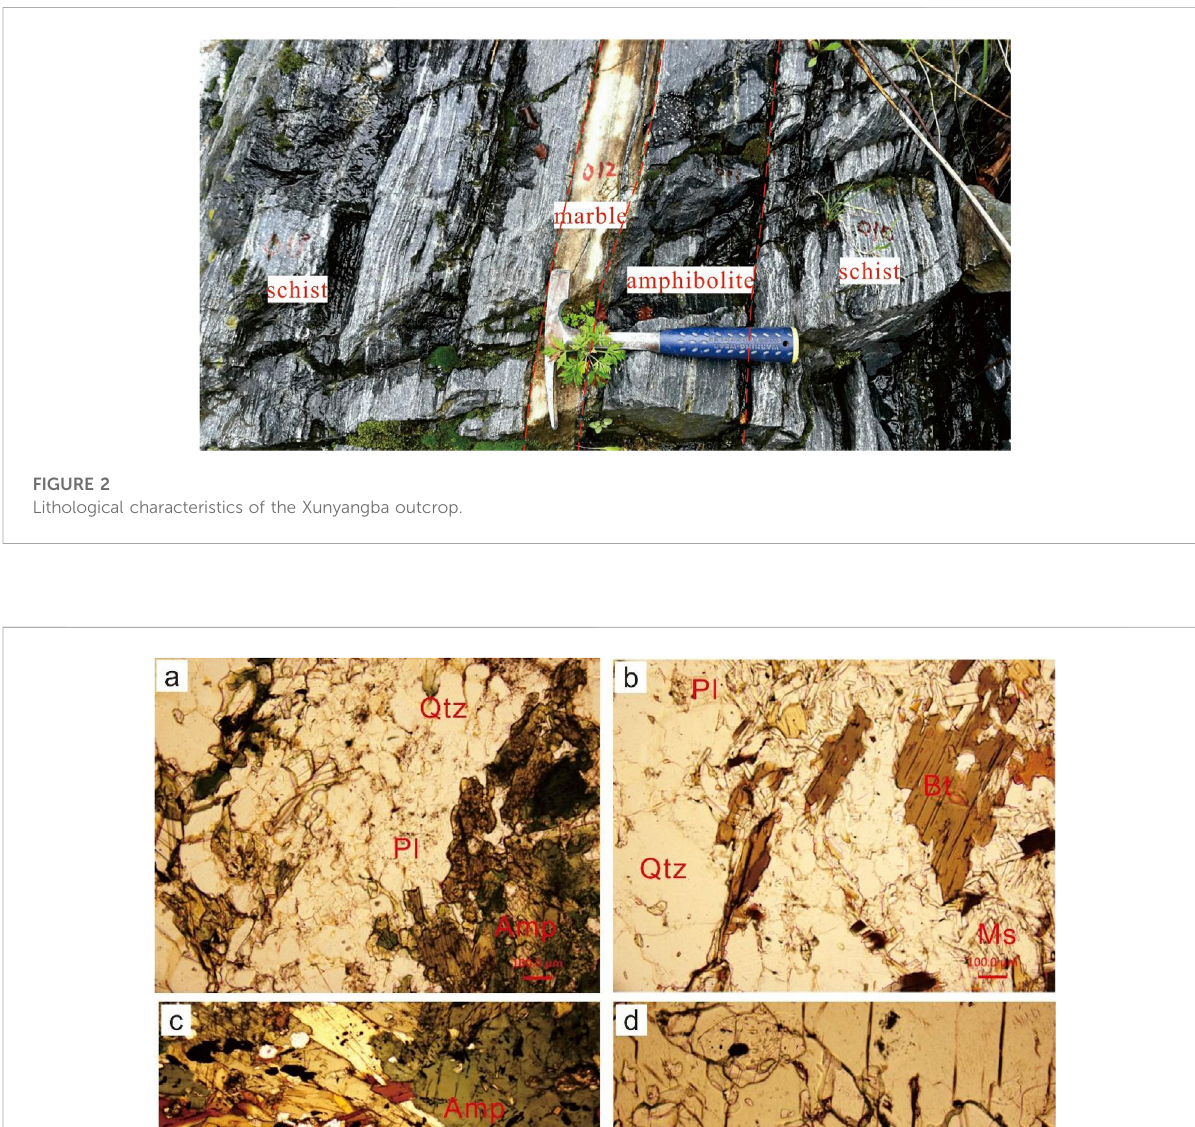
schist, and marble (Figure 2). The amphibolite and schist are mainly banded, while the marble is banded or lenticular.